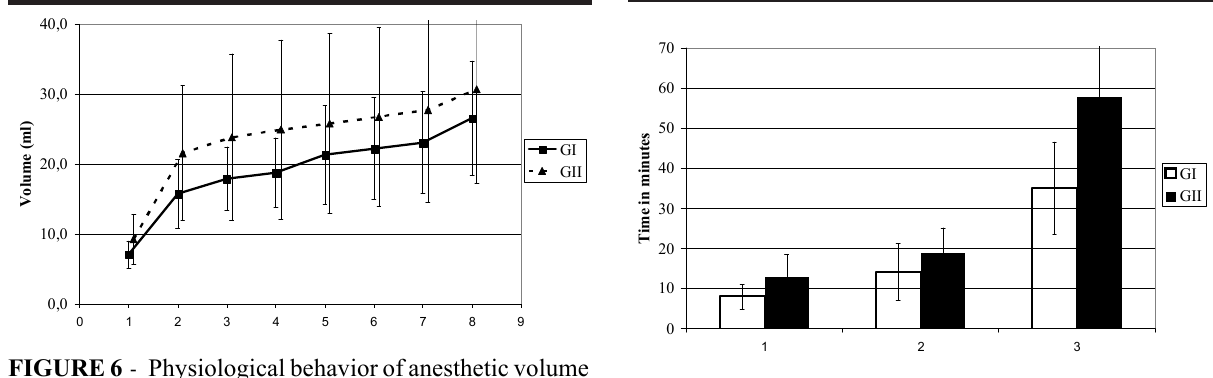
FIGURE 7 - Recuperation periods, 1=Extubation, 2=Sternal recumbency and 3=Quadrupedal posture in minutes in G1 and